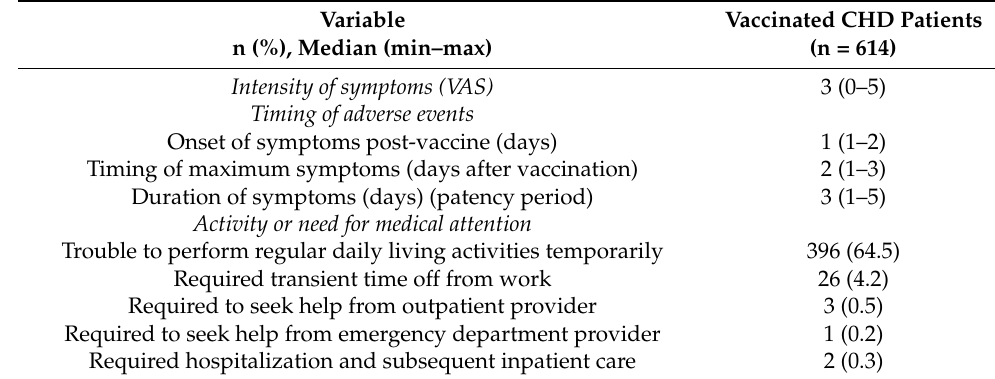
Table 5. Univariate and multivariate regression analysis used to determine factors associated